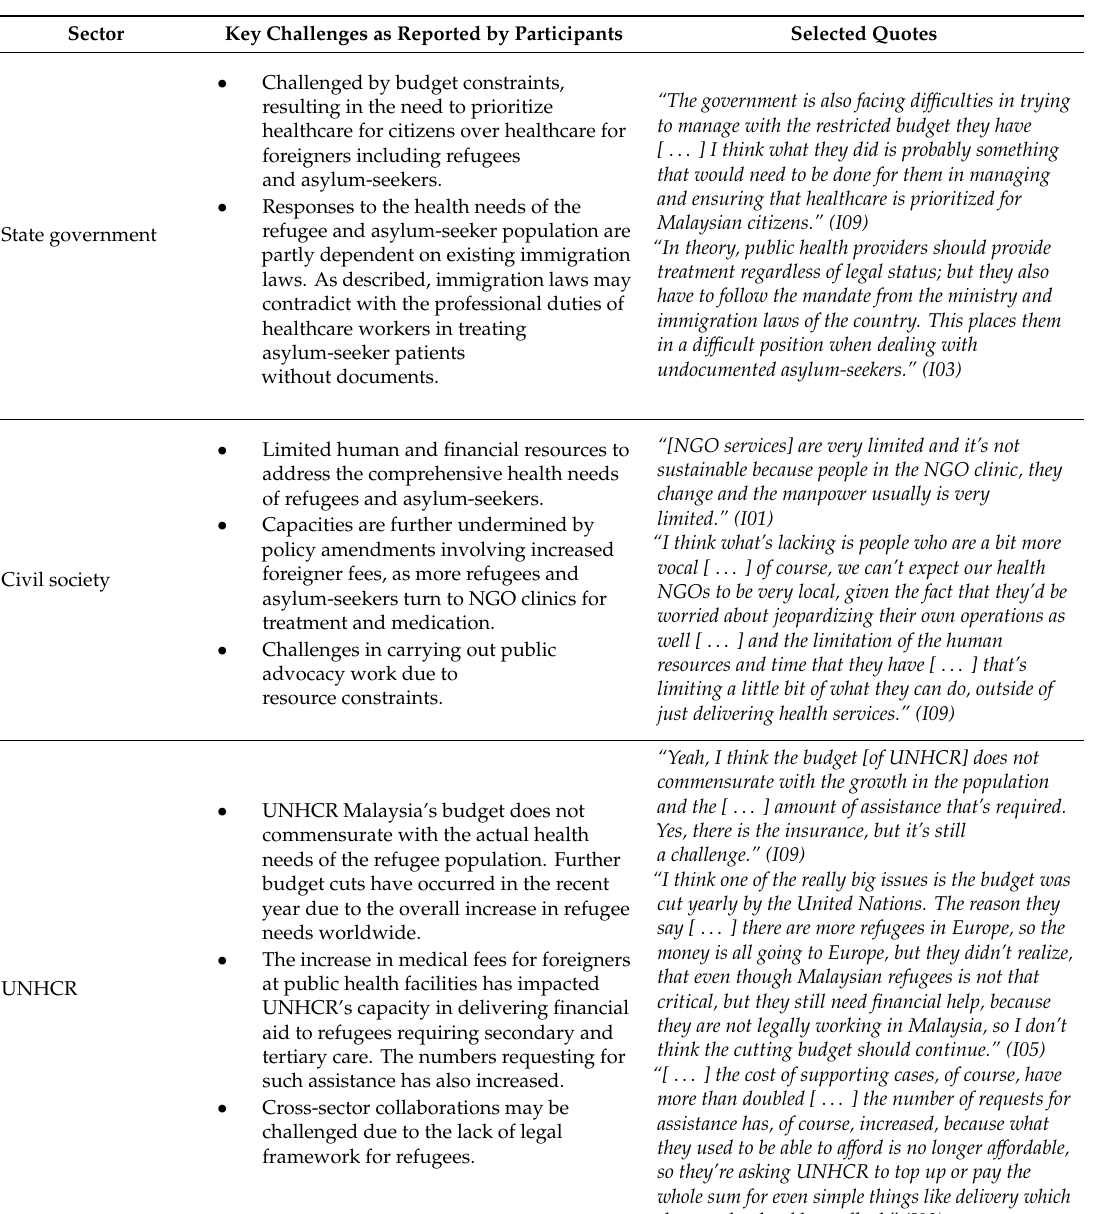
Table 2. Key challenges faced by actors in responding to refugee health issues in